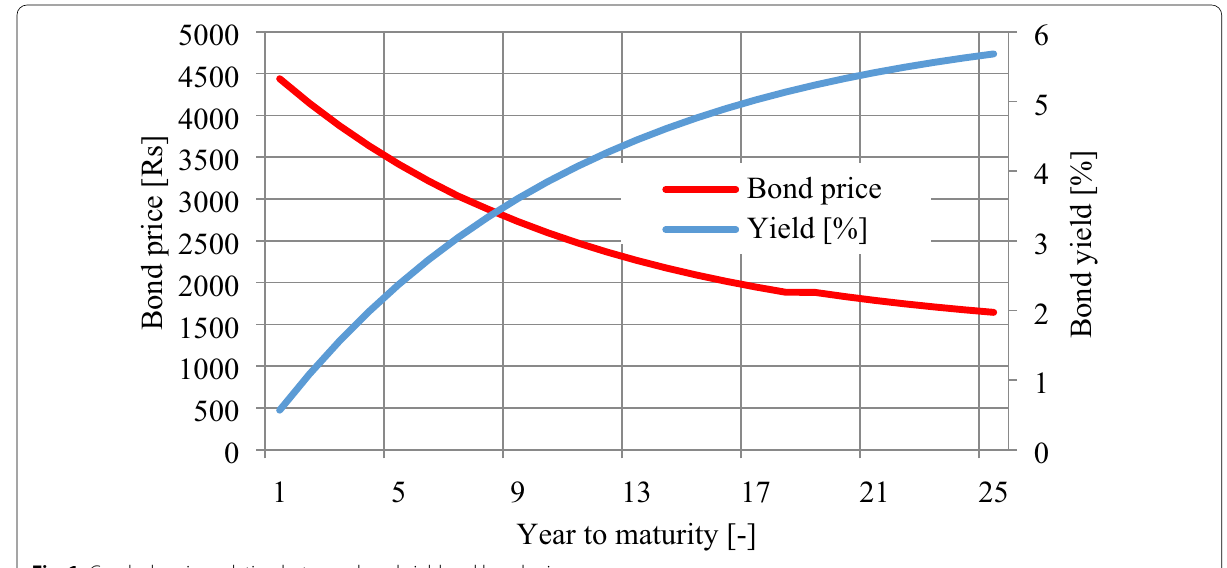
Fig. 1 Graph showing relation between bond yield and bond